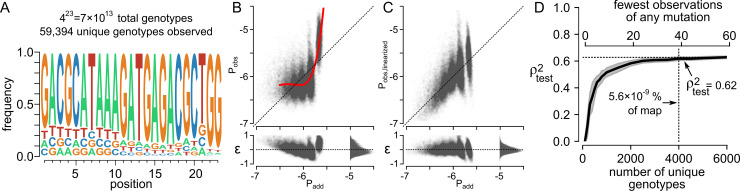
A predictive, additive model can be trained on a large genotype-phenotype map.A) Summary of the genotype-phenotype map [55].The map consists of 23 sites, each with four bases with the frequency at each site shown in the sequence logo. The total map has 7 × 1013 genotypes; the phenotypes of 59,394 genotypes have been measured. B) Raw Pobs vs. Padd plot for the map. Each point is a genotype. The fit residuals are shown below the main plot. We fit an 5th-order spline to linearize the map (red curve). C) The linearized form of the map, with epistasis removed using the spline shown in panel B. D) A predictive model can be trained using approximately 4,000 genotypes. The bottom x-axis shows the number of unique genotypes used to train the model (sampled randomly); the top x-axis shows the fewest number of times any mutation was seen in that sample. R2test was measured against the remaining 50,000+ genotypes not used to train the model.